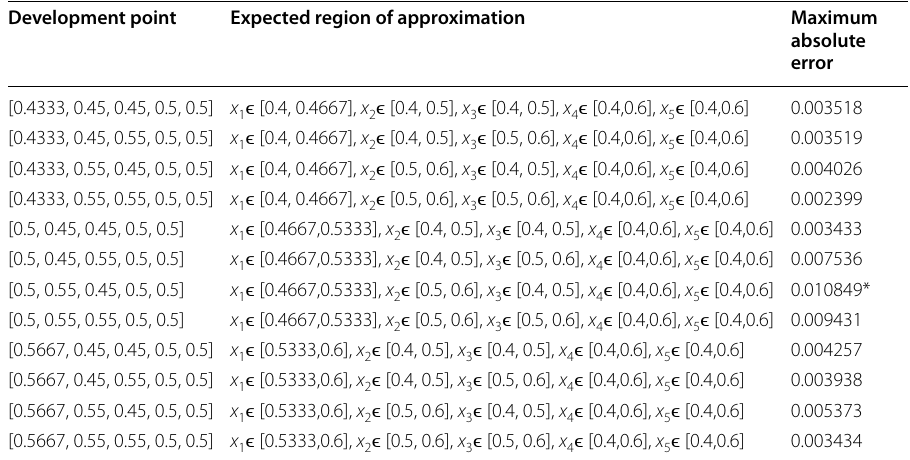
Table 4 Development points and expected region of